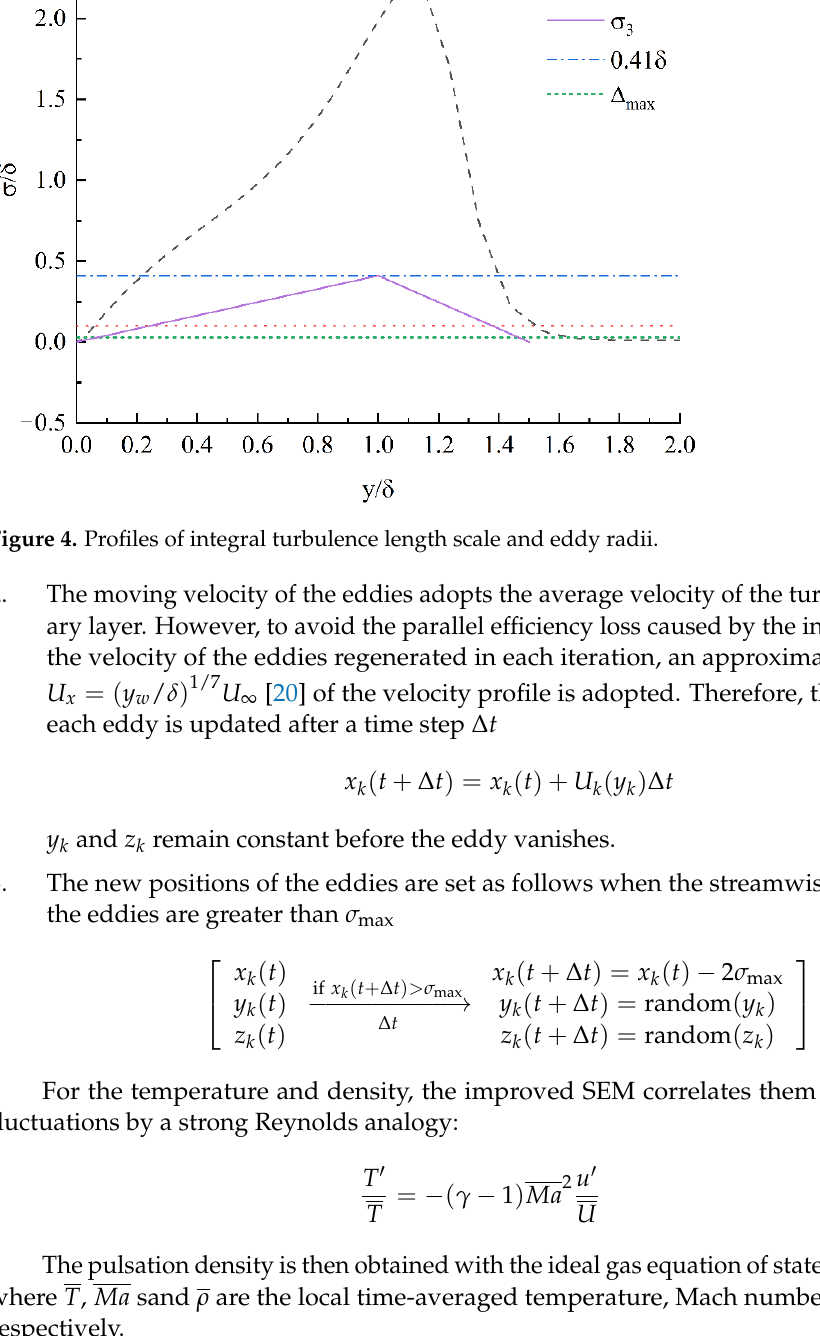
Figure 5. Root mean square distributions of the velocity fluctuations within the boundary layer ex- tracted from DNS results.